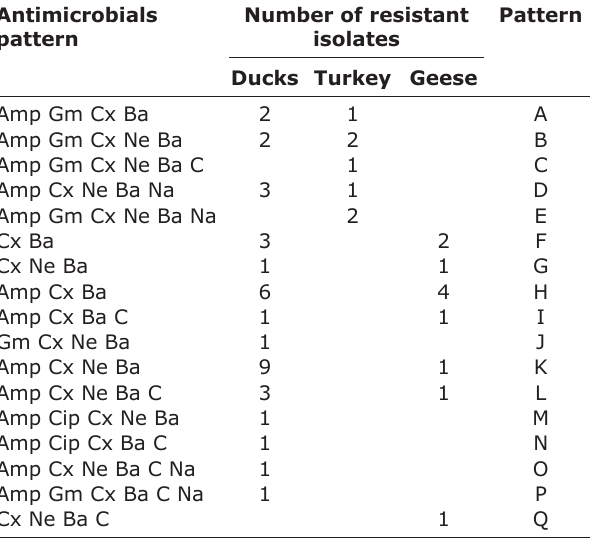
Table-2: Antimicrobial resistance patterns for AFEC isolates. Antimicrobials pattern